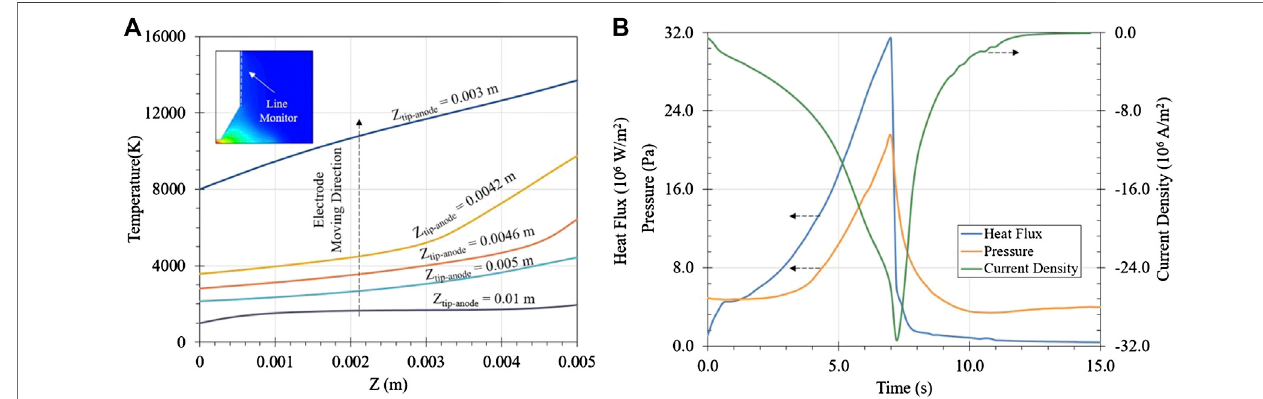
FIGURE 7 | (A) Near-wall gas temperature distribution at the electrode surface during the electrode descent. (B) Distribution of the heat fl ux, pressure and current density at the anode surface during the electrode descent.